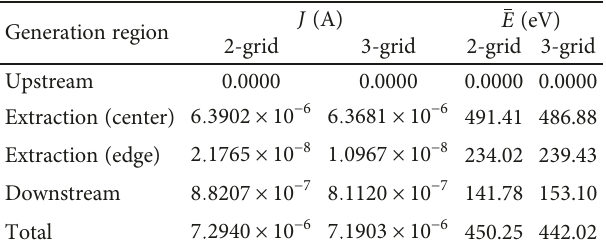
Table 9: CEX impingement current of the accelerator grid J and mean incident energy E from di ff erent regions at n 0 = 2 0